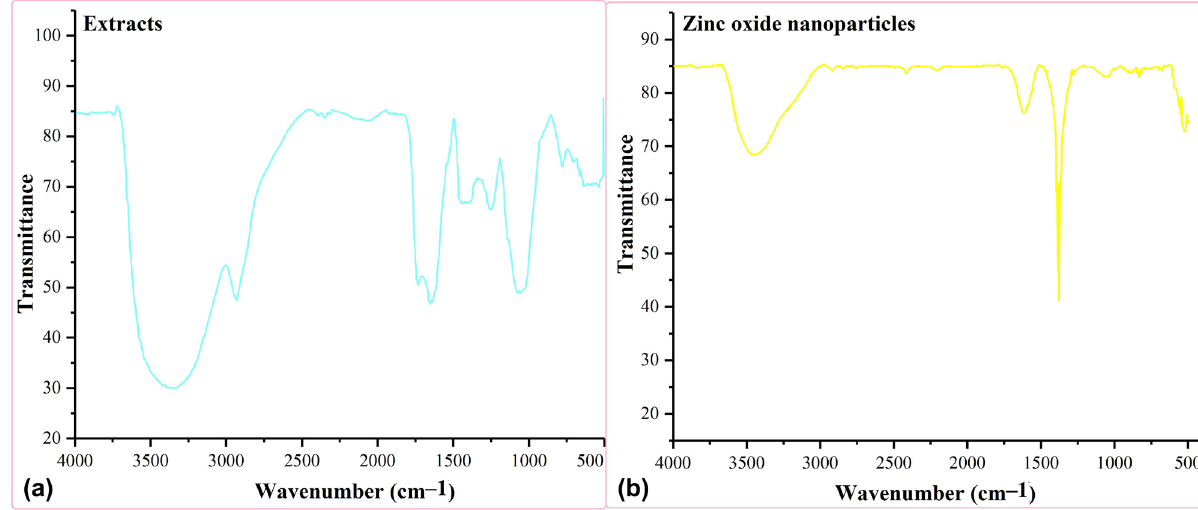
Figure 3: FTIR spectra of ( a ) extracts and ( b ) biosynthesized ZnONPs.